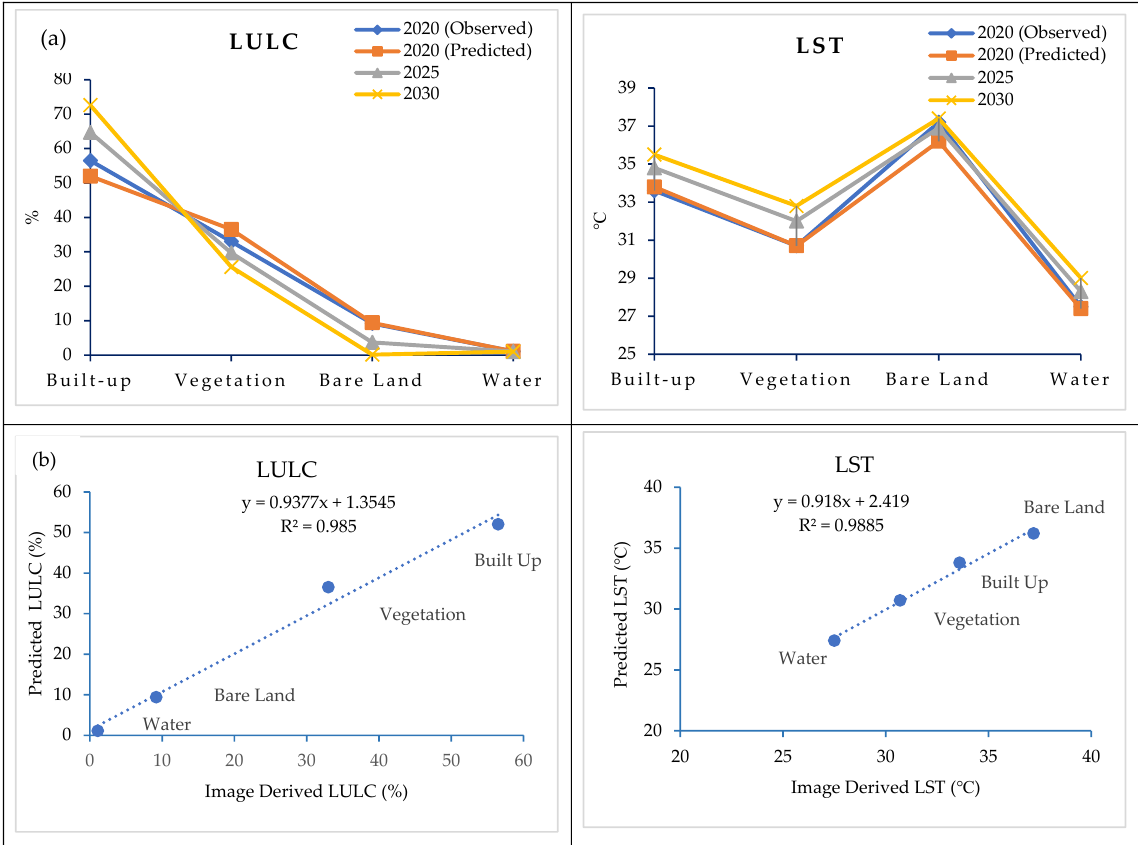
Figure 10. Relationship between Built-up area and LST.